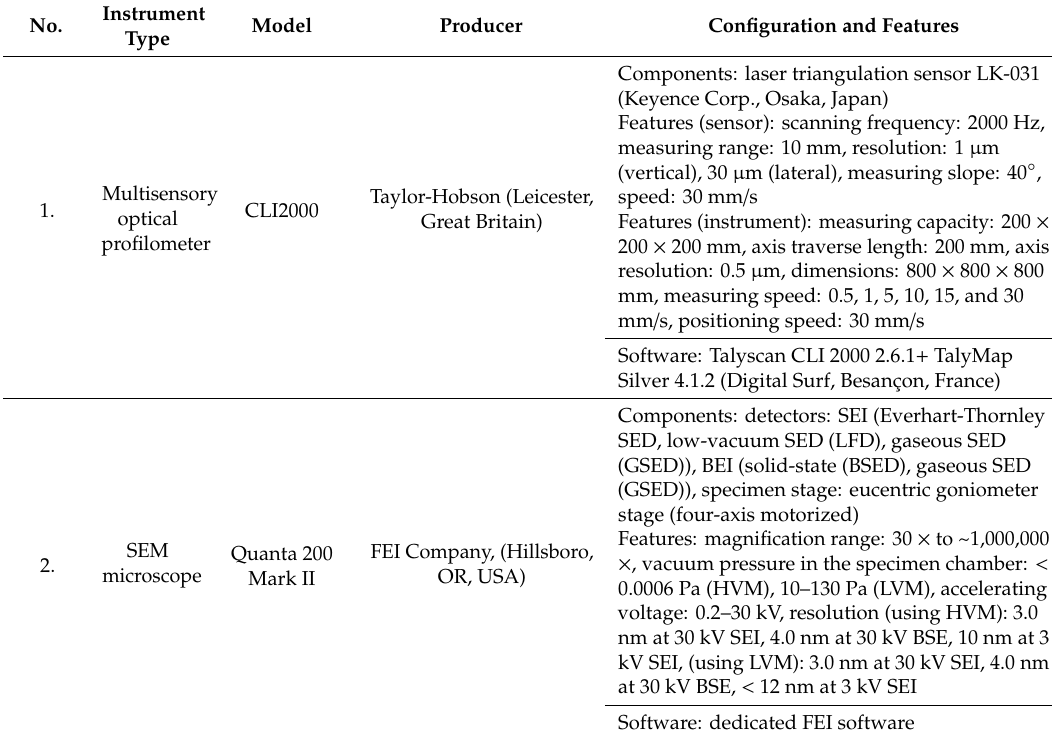
Table 3. Characteristics of observation / measurement systems used in experimental